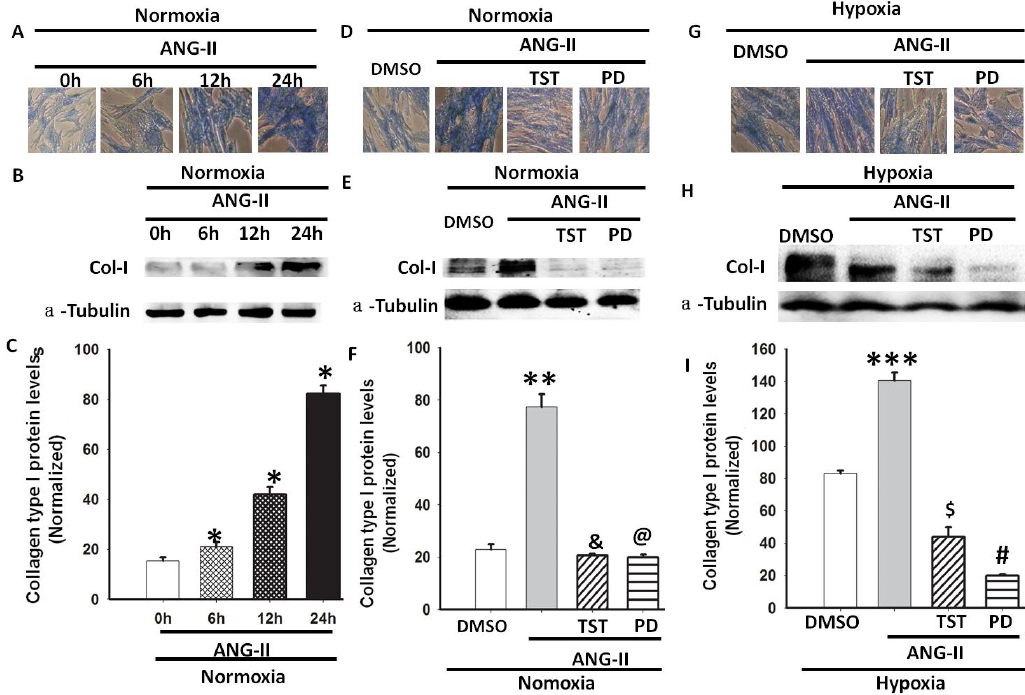
Figure 4. The role of the ATR in Ang II-induced Col-I expression under normoxia and hypoxia. ( A ) A Masson staining assay was used to observe the changes in the total collagen content in HLF-1 cells after treatment with Ang II (1.0 μ M) for 0, 6, 12 or 24 h. The total collagen content increased after Ang II treatment in a time-dependent fashion; ( B ) Col-I protein expression was measured using Western blot analysis; ( C ) Normalisation of Col-I expression to α -tubulin. The data are presented as means ± SD ( n = 3). * p < 0.05 vs. 0 h following the Ang II exposure; ( D ) A Masson staining assay was used to observe the changes in the total collagen content in HLF-1 cells after Ang II treatment (1.0 μ M) for 24 h with the presence or absence of 50 μ M TST or 10 μ M PD123319 (PD) under normoxic conditions; ( E ) Col-I protein expression was measured using Western blot analysis; ( F ) Normalisation of the Col-I expression to α -tubulin. The data are presented as means ± SD ( n = 3). ** p < 0.05 vs. DMSO. & p < 0.05 vs. Ang II; @ p < 0.05 vs. Ang II; ( G ) A representative picture of the Masson staining in HLF-1 cells treated with Ang II (1.0 μ M) for 24 h with the presence or absence of 50 μ M TST or 10 μ M PD123319 (PD) under hypoxic conditions for 24 h; ( H ) Col-I protein expression was measured using Western blot analysis; and ( I ) Normalisation of Col-I expression to α -tubulin. The data are presented as means ± SD ( n = 3). *** p < 0.05 vs. DMSO; $ p < 0.05 vs. Ang II; # p < 0.05 vs. Ang